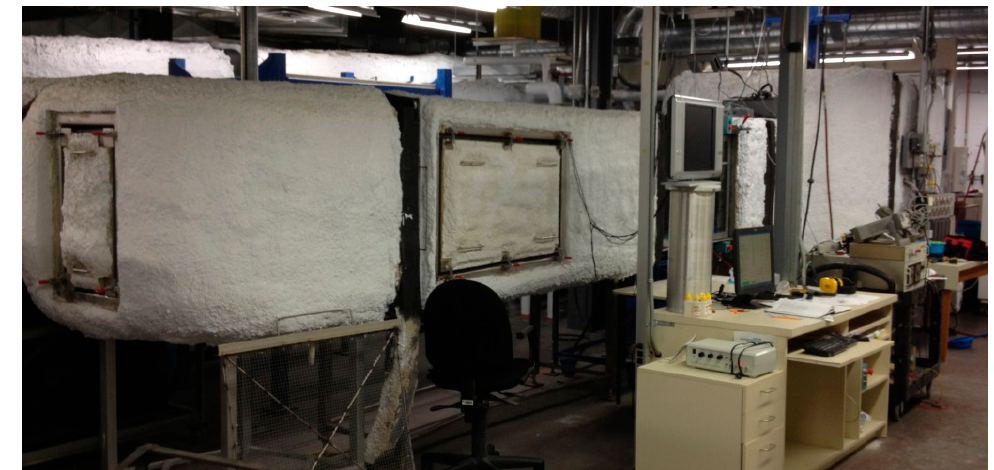
Figure 1. Icing wind tunnel.